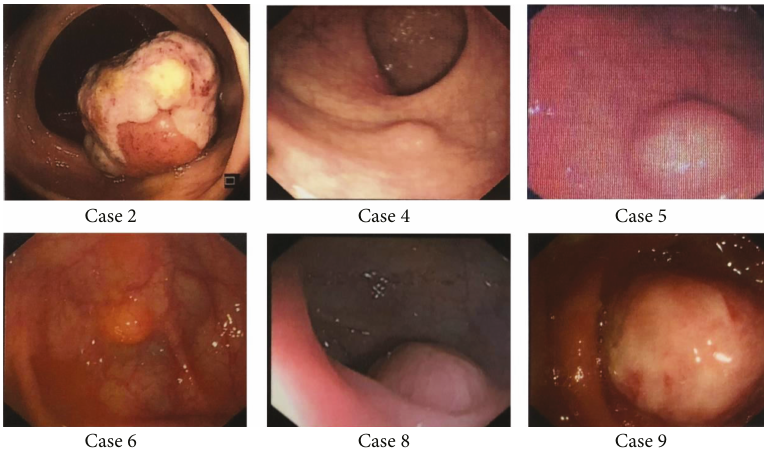
Figure 3: Colonoscopy showing submucosal masses with no obvious